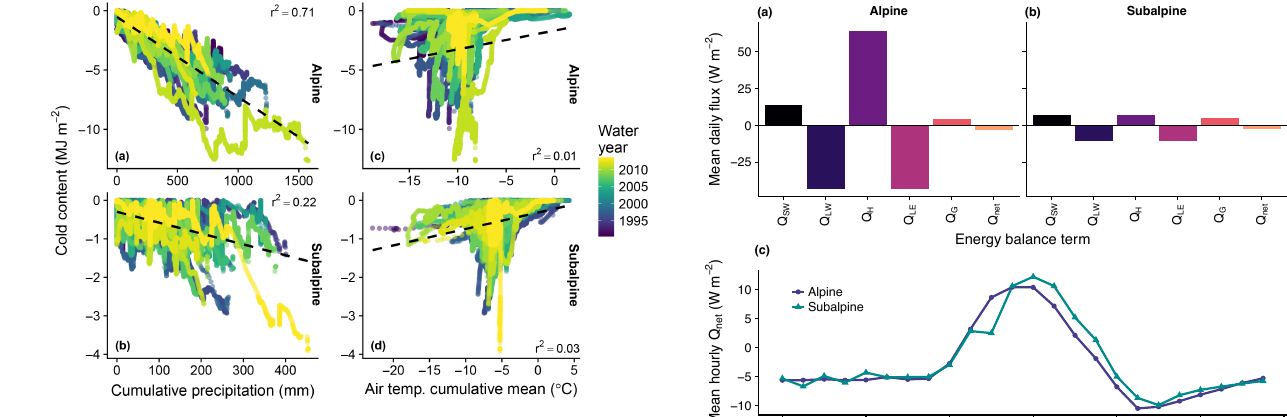
Figure 6. Simulated cold content plotted against cumulative pre- cipitation in the alpine (a) and subalpine (b) , and the cumulative mean of air temperature in the alpine (c) and subalpine (d) . Shading denotes the corresponding water year.